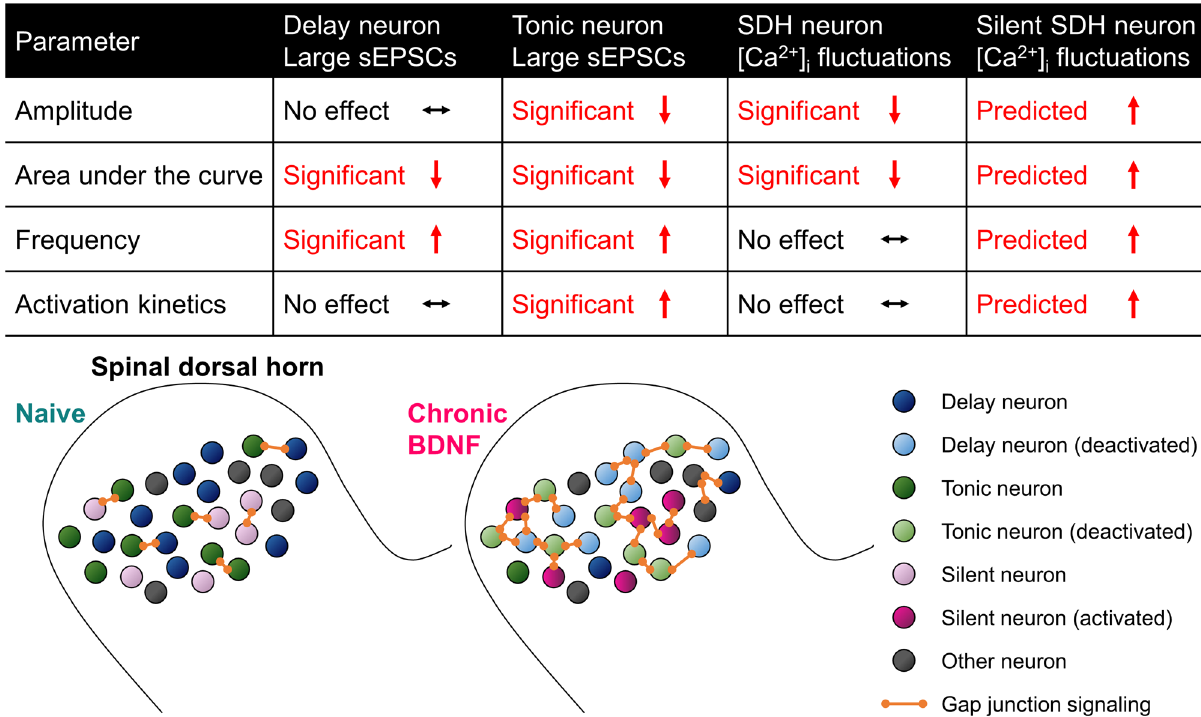
Figure 6. Working model summarizing the effects of chronic BDNF on SDH neurons in this